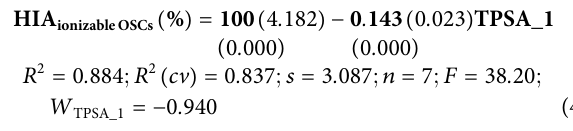
Frontiers in Chemistry |